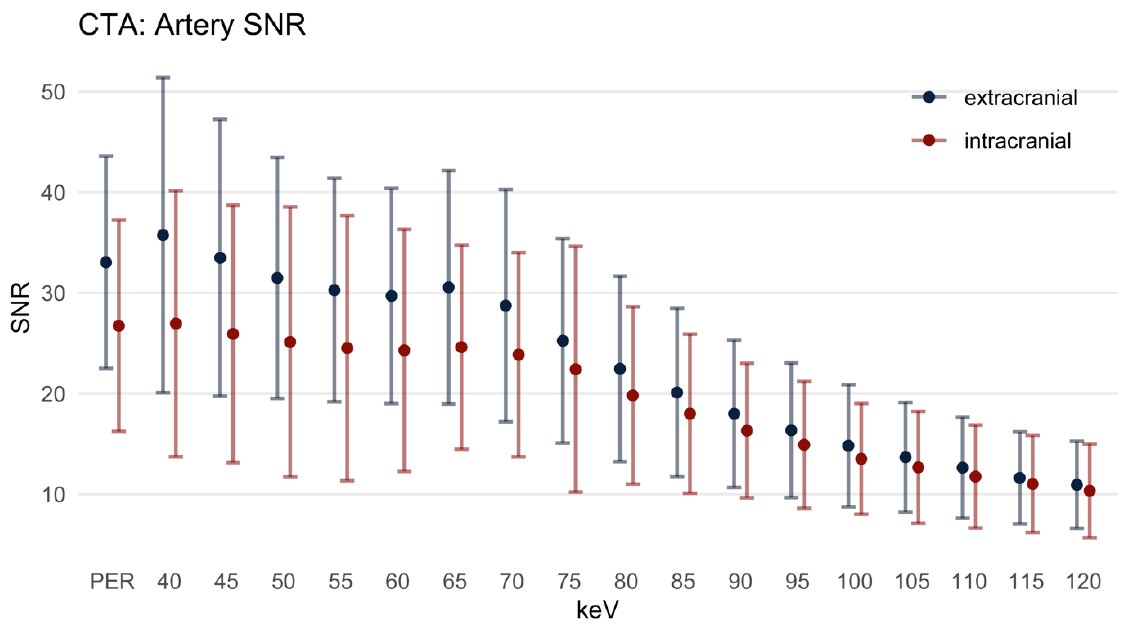
Figure 4. Signal-to-noise ratio, mean ± SD. PER: polyenergetic reconstruction; keV: keV level of the monoenergetic reconstruction. Extracranial: internal carotid artery C1 segment and vertebral artery V3 segment; intracranial: internal carotid artery C4 segment and basilar artery.